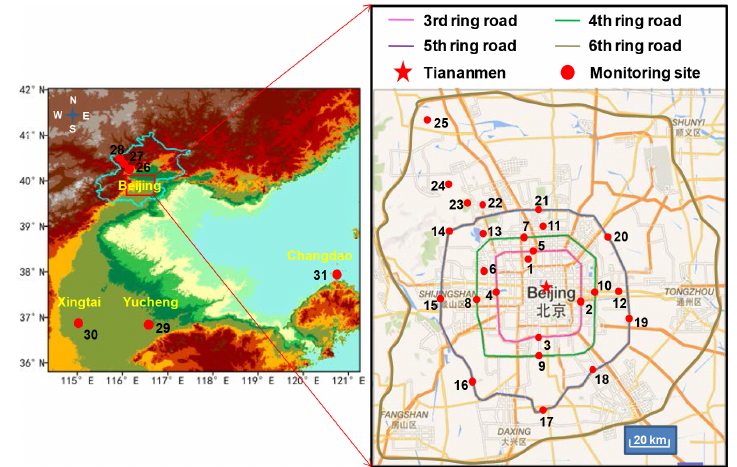
Figure 1. Maps showing the 31 monitoring sites, the Beijing municipality (the areas within the blue line) and the surrounding regions. Also shown are locations of Tiananmen and the third, fourth, fifth and sixth ring